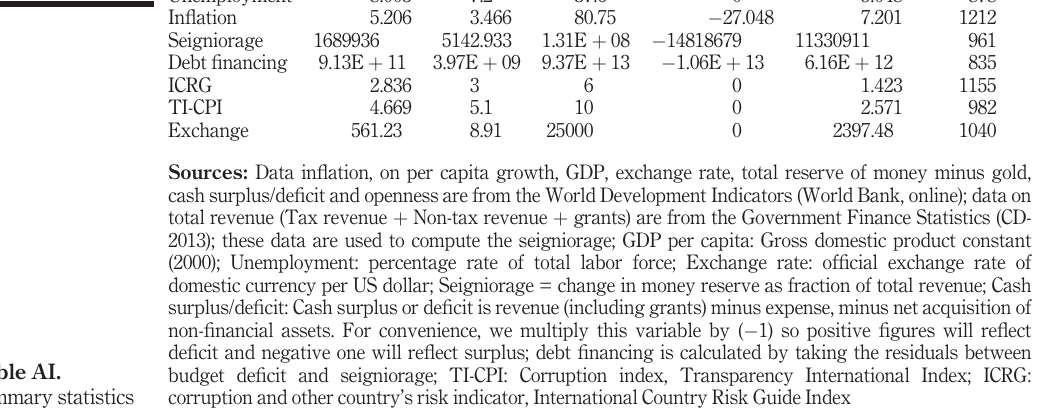
Table AI. Summary